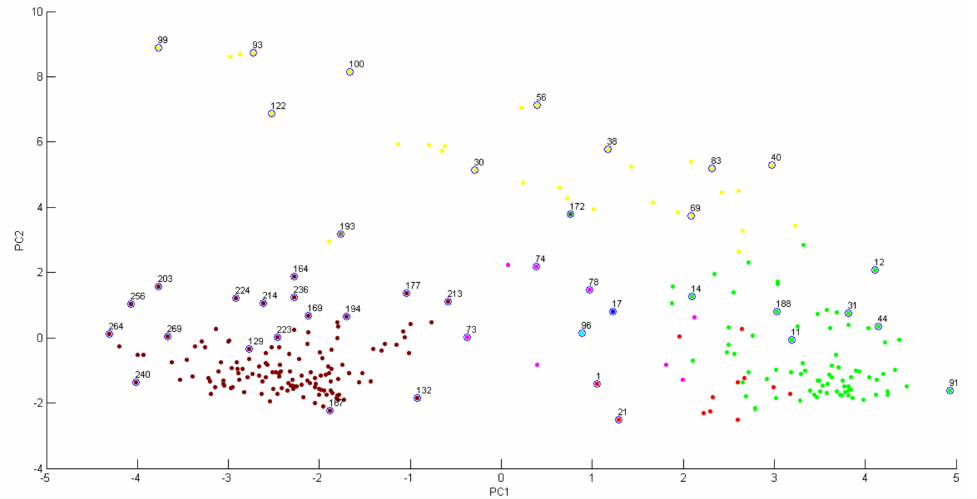
Figure 6. Maldi Biotyper PCA Clustering analysis of infected and healthy C. sinensis leaves samples. The numbers indicate the treatments of the plant tissues: 1 to 128 = IT; 129 a 270 = HT.